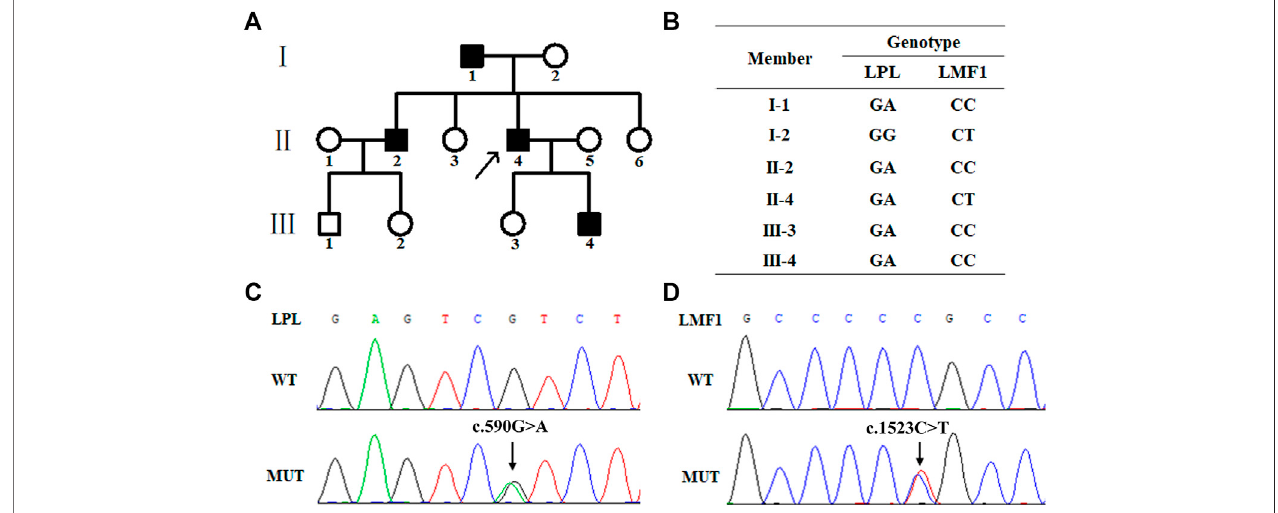
FIGURE1| Familypedigreeandmutationscreeningofsamplesfromafamilywithhypertriglyceridemia. (A) .Familypedigree.Thearrowindicatestheproband. (B) . The genotype ofsixfamily members.Theproband ( Π 4), I1, z 4and z 3carrytheheterozygous missense mutation(c.1523C > T)in the LPL gene.The proband ( Π